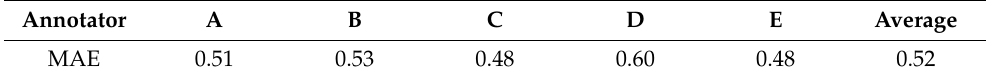
Table 2. MAE of the five annotations and the final classification results.